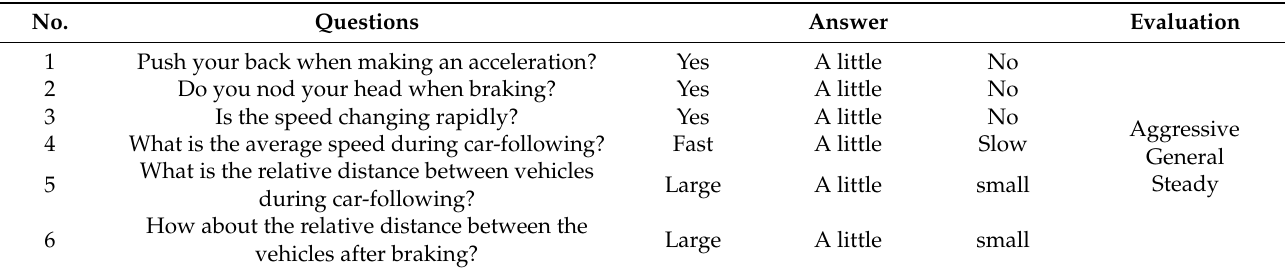
Table 1. The questionnaire for occupant